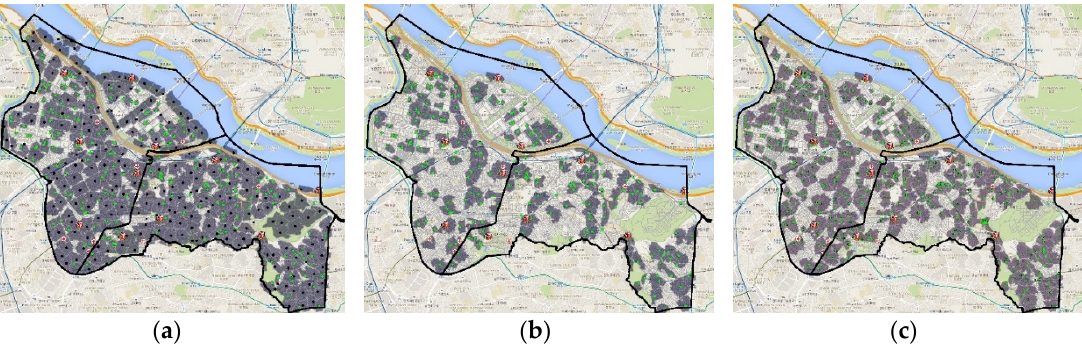
Figure 15 . Coverage area comparison. ( a ) Additionally installed and pre-installed AEDs (455 AEDs). ( b ) “Filtered” pre-installed AEDs (227 AEDs). ( c ) Total pre-installed AEDs (432 AEDs).